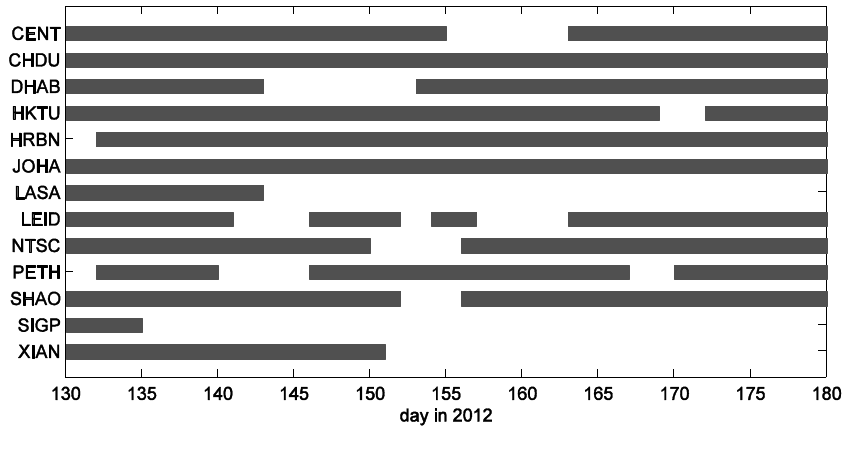
Figure 2. Daily data availability of the 13 selected tracking stations over the testing period.